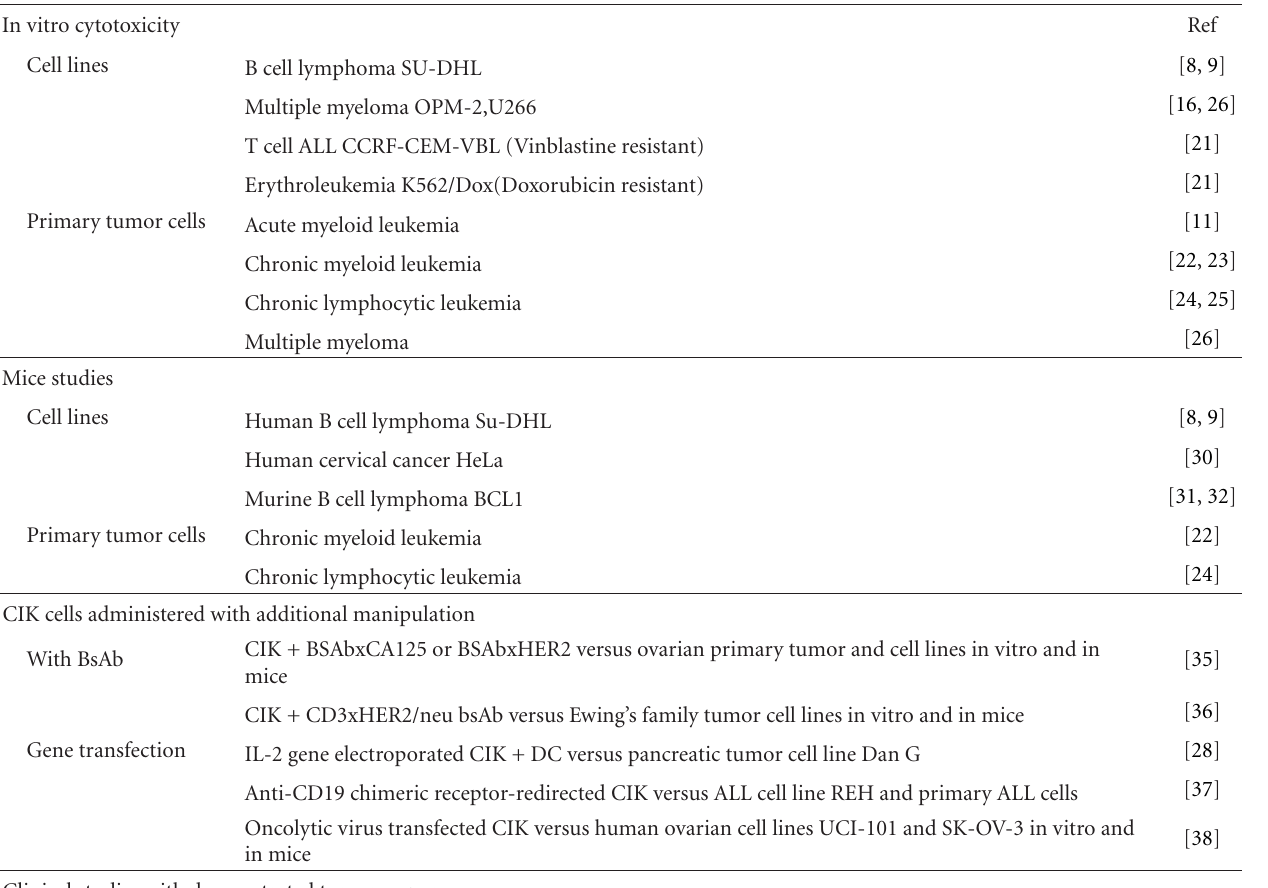
Table 2: Activities of CIK cells from preclinical experiments to clinical